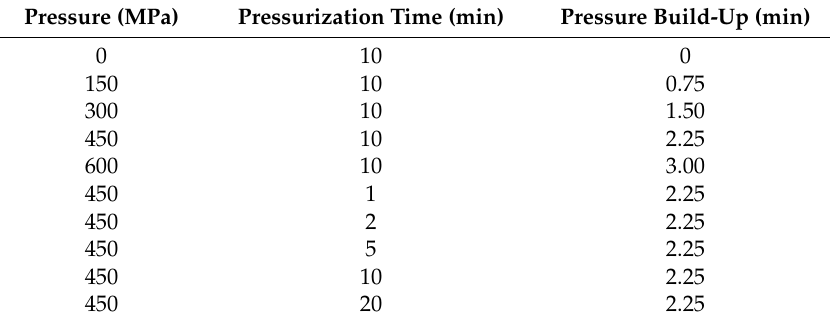
Table 1. High-pressure treatment (HPT) parameters applied to wheat flour sample and pressure built-up